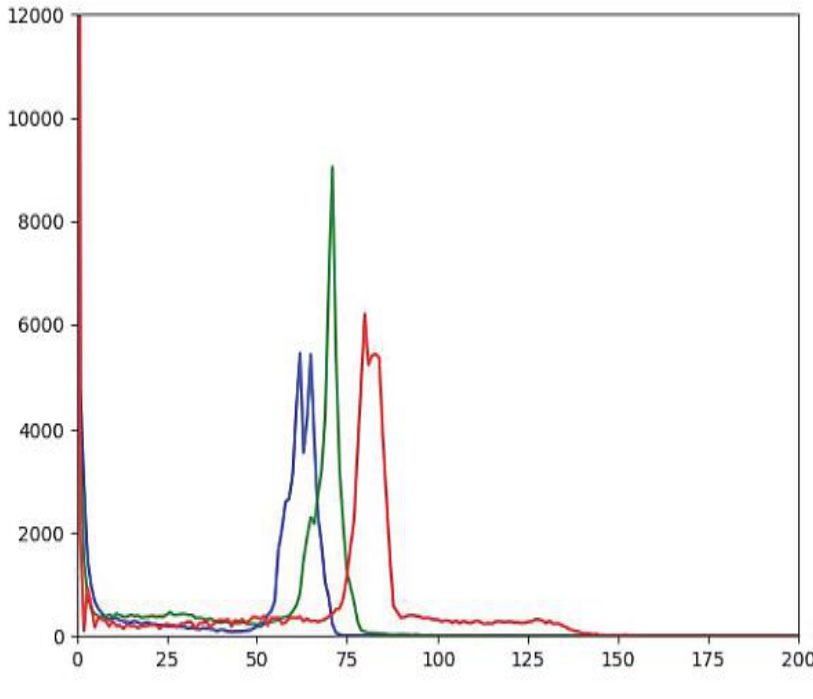
Figure 24. Histogram of the RGB graph for the image (see Figure